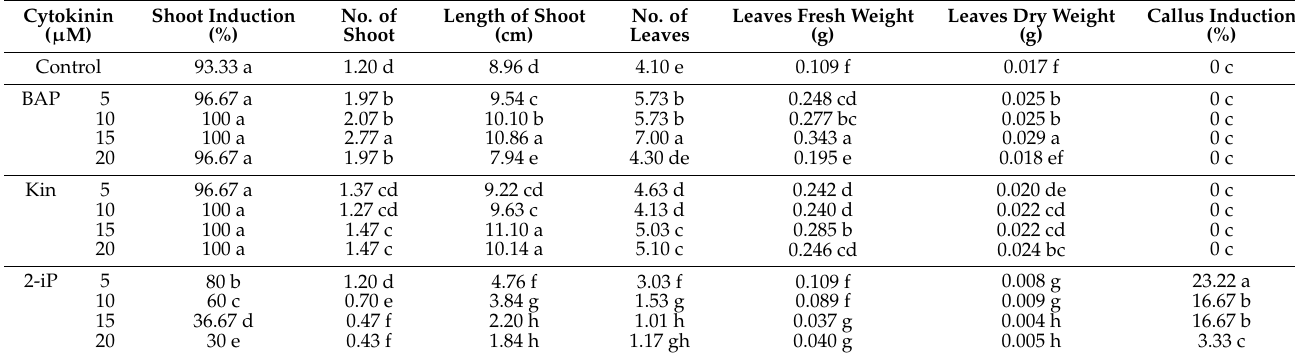
Figure 2. Shoot multiplication of C. caesia in MSB5 medium supplemented with 15 μ M BAP at eight weeks after inoculation. Scale bar represents 1 cm of actual size.